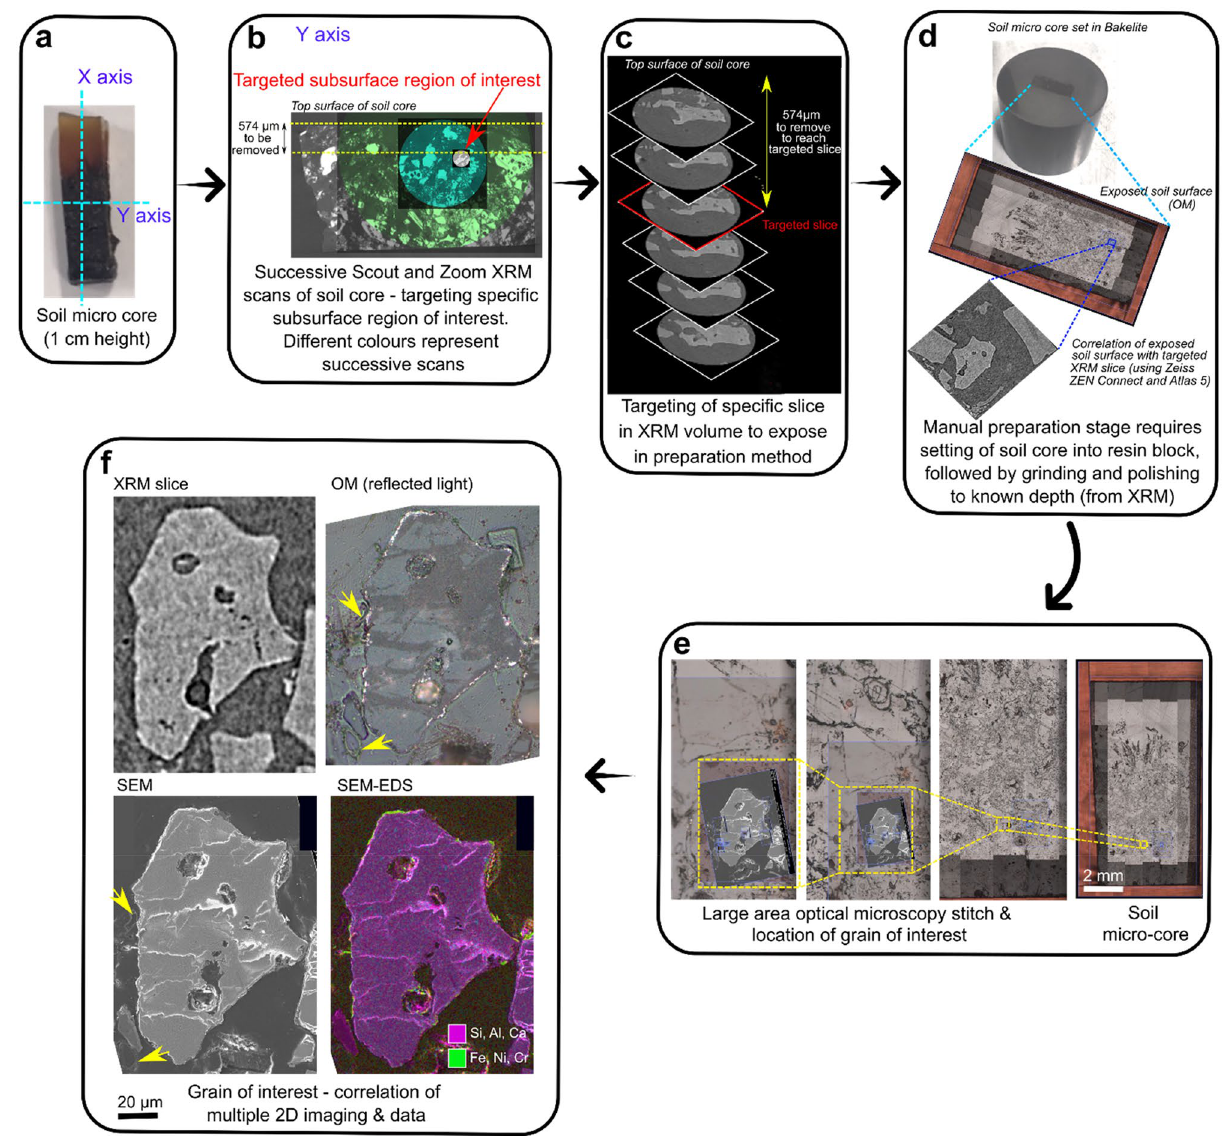
Figure 3. Additional correlative sample preparation step, revealing grain and slice of interest for further study via other imaging and chemical methods. (a) Axis orientations of soil micro-core. (b) Progressively higher resolution 3D volumes obtained from XRM are correlated, focussing on grain of interest (red arrow). (c) An assessment of depth of material to be removed (and from which axis) determined from XRM scans. Targeted slice from XRM scans at 574 µm depth. (d) Soil micro-core mounted in bakelite, and manually ground and polished to remove specific depth of material (574 µm); measurements taken regularly using a calliper